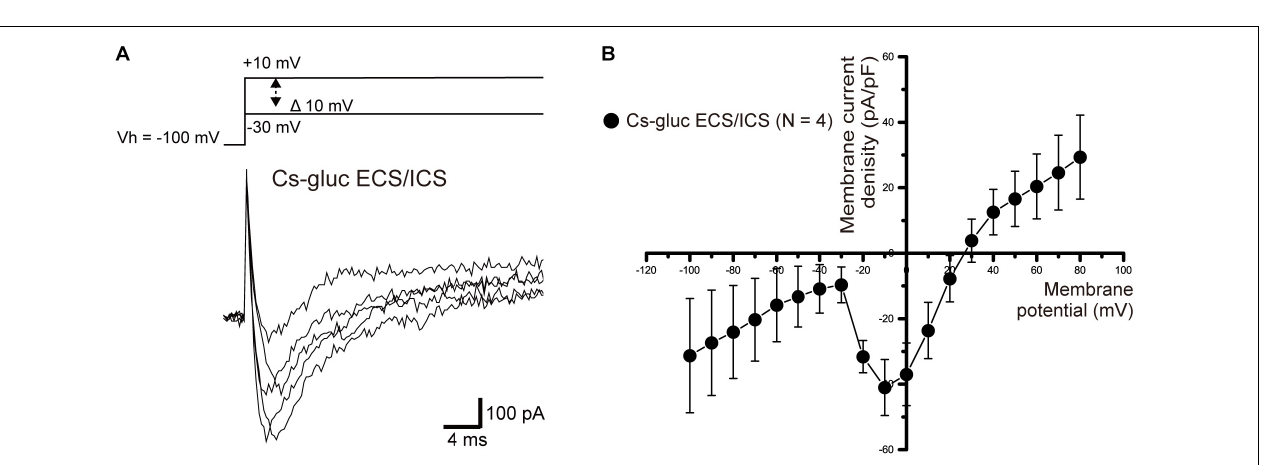
FIGURE 9 | Inward currents under the Cs-Gluc-ECS/ICS . (A) Under the Cs-gluc-ECS/ICS, when (400 ms) voltage was applied in 10 mV increments from –30 to +10 mV at a Vh of –100 mV (upper traces), an inward current component appeared. (B) Current-voltage relationships (I-V curves) of the inward currents are shown. The horizontal axis indicates the membrane potential applied and the vertical axis represents the current density. I-V curves were obtained by plotting the values of the peak current amplitude as densities against the applied membrane potentials. Each point represents the mean ± SE current density of four cells.